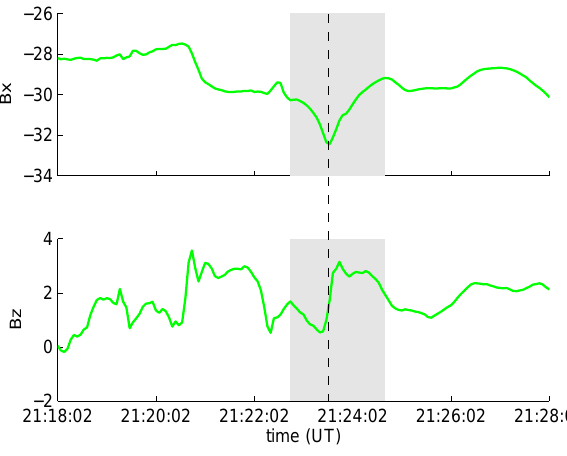
Fig. 7. TCR3: B x and B z observed by C3 during a period with quite strong fluctuations in B z . The increase in the value of | B x | at 21:23:34UT indicates a TCR and is consistent with the variation in B z .